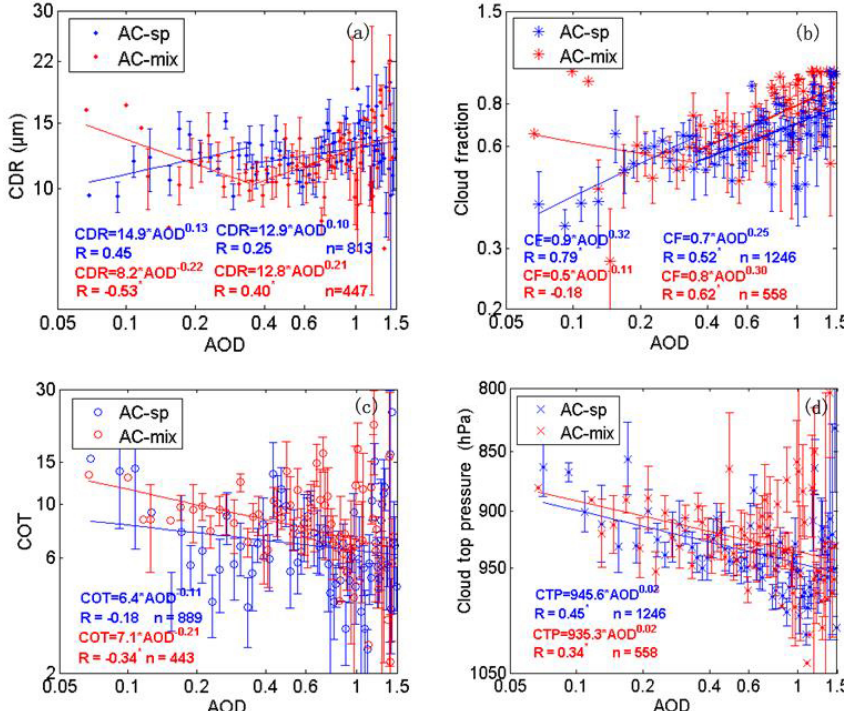
Figure 6. Scatter plots of cloud parameters versus AOD over YRD on log–log scale for cases of separated (blue) and mixed (red) aerosol– cloud layers: (a) CDR versus AOD, (b) CF versus AOD, (c) COT versus AOD and (d) CTP versus AOD. The lines present the least-square fits, and the resulting relations are presented in each figure. Error bars represent the confidence level of the mean cloud parameters’ value for each AOD bin, i.e. the statistical uncertainties, expressed as σ/(n − 2 ) , where n is the number of cases within the AOD bin and σ is the standard deviation of cloud